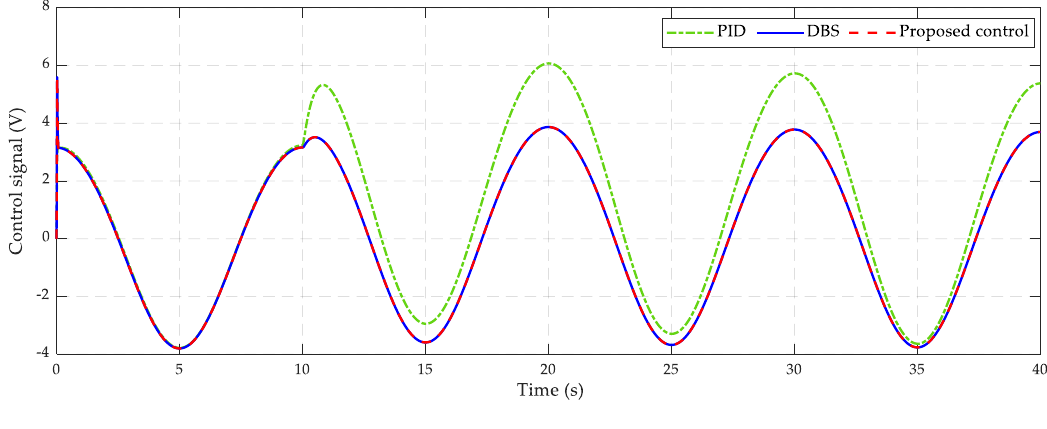
Figure 6. The control input signals.